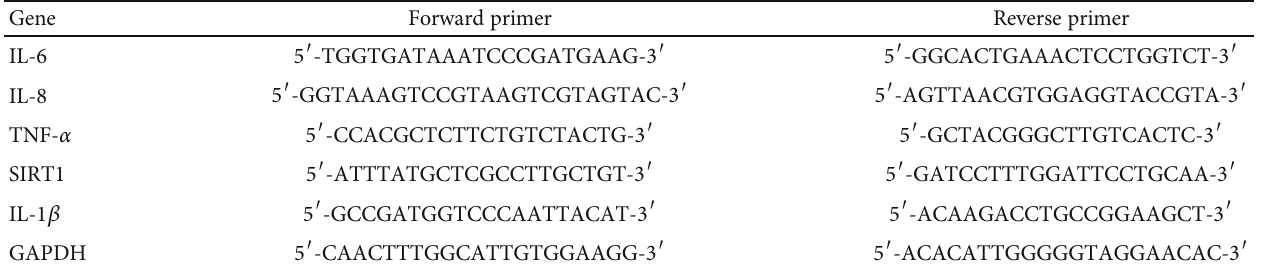
Figure 1: Detailed experimental protocol representing the treatment of GBP (a). E ff ects of GBP on the paw withdrawal latency (b) and paw withdrawal threshold (c) in normal rats. Data were expressed as the mean ± SD ( n = 8 for each group). Table 1: Sequences of primers used quantitative real-time PCR.